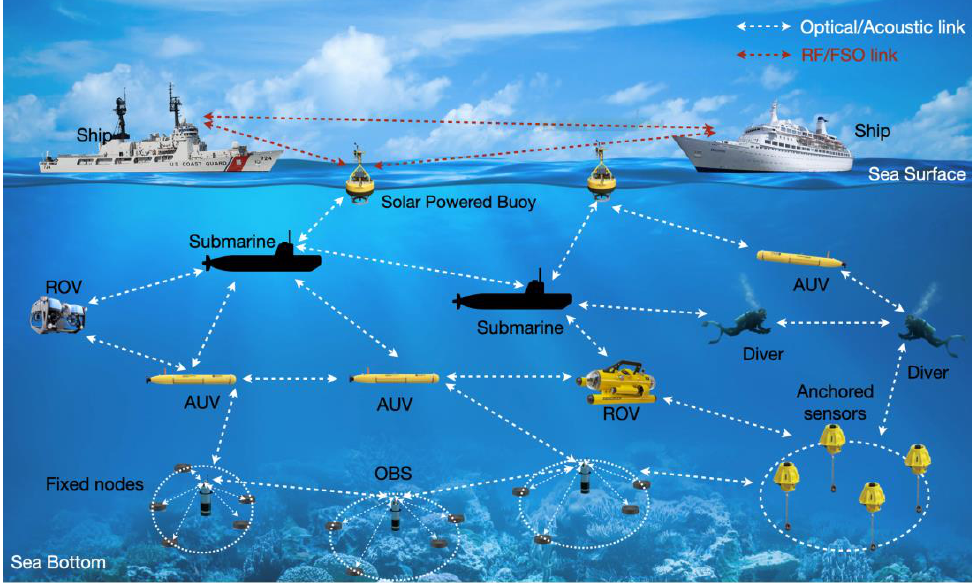
Figure 1. Architecture of an underwater wireless communication sensor network.